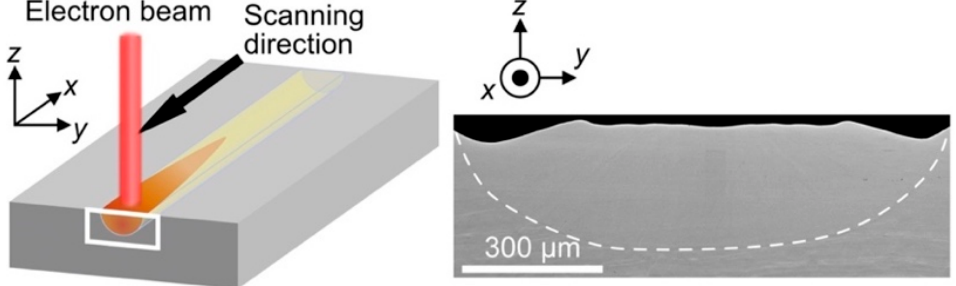
Figure 2. A typical example of a cross-sectional SEM image taken from the electron-beam irradiated region of 304 SS. P and V are 900 W and 100 mm/s, respectively. The dashed line indicates the fusion line.